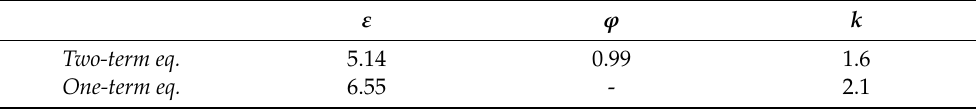
Table 6. Summary of parameters defined for the 𝐸̃ 𝑘𝑖𝑛𝑐𝑟𝑖𝑡 equation. 𝜺 𝝋 k Two-term eq. One-term eq.